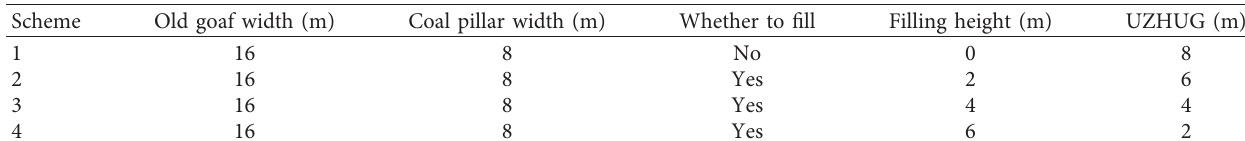
Table 2: Numerical simulation schemes.